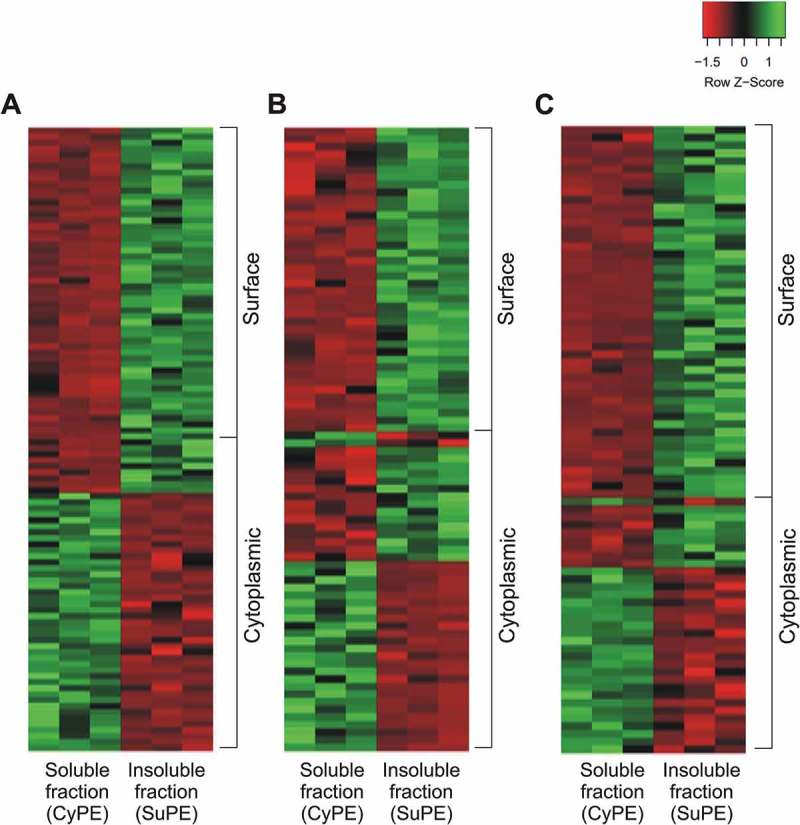
Heatmaps showing the enrichment of surface-related proteins in insoluble extracts of (A) M. hyopneumoniae 7448, (B) M. hyopneumoniae J, and (C) M. flocculare. In each heat map, all shared proteins showing statistically significant abundances (p < 0.05) between soluble (CyPE) and insoluble (SuPE) fractions are represented (red, low abundance; green, high abundance). Distribution of surface and cytoplasmic-predicted proteins are indicated on the right. NSAF values, converted in Z-scores, were used to quantify relative differences in protein abundance, and the t-test was applied to determine statistically significant differences between shared proteins.